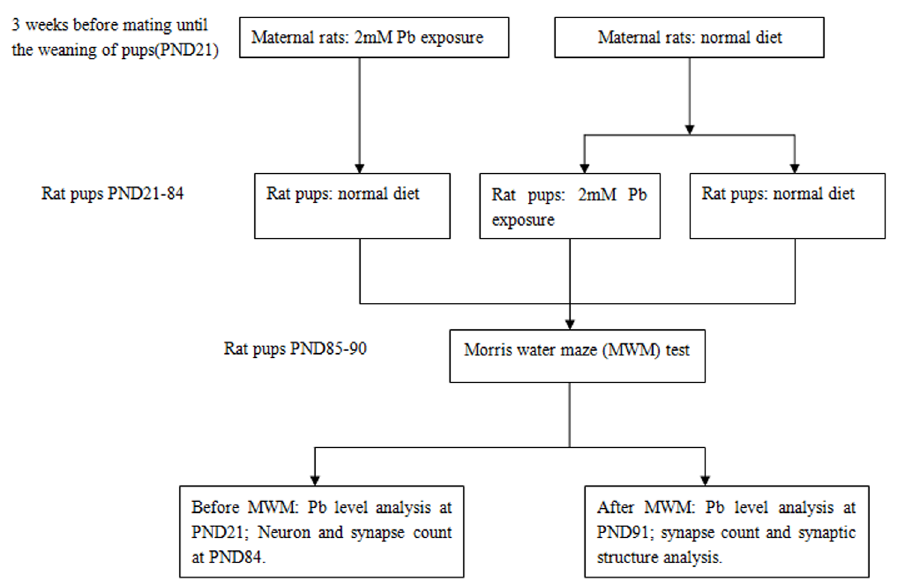
Fig. 1. The flowchart depicting exposure protocols and time duration of exposure.